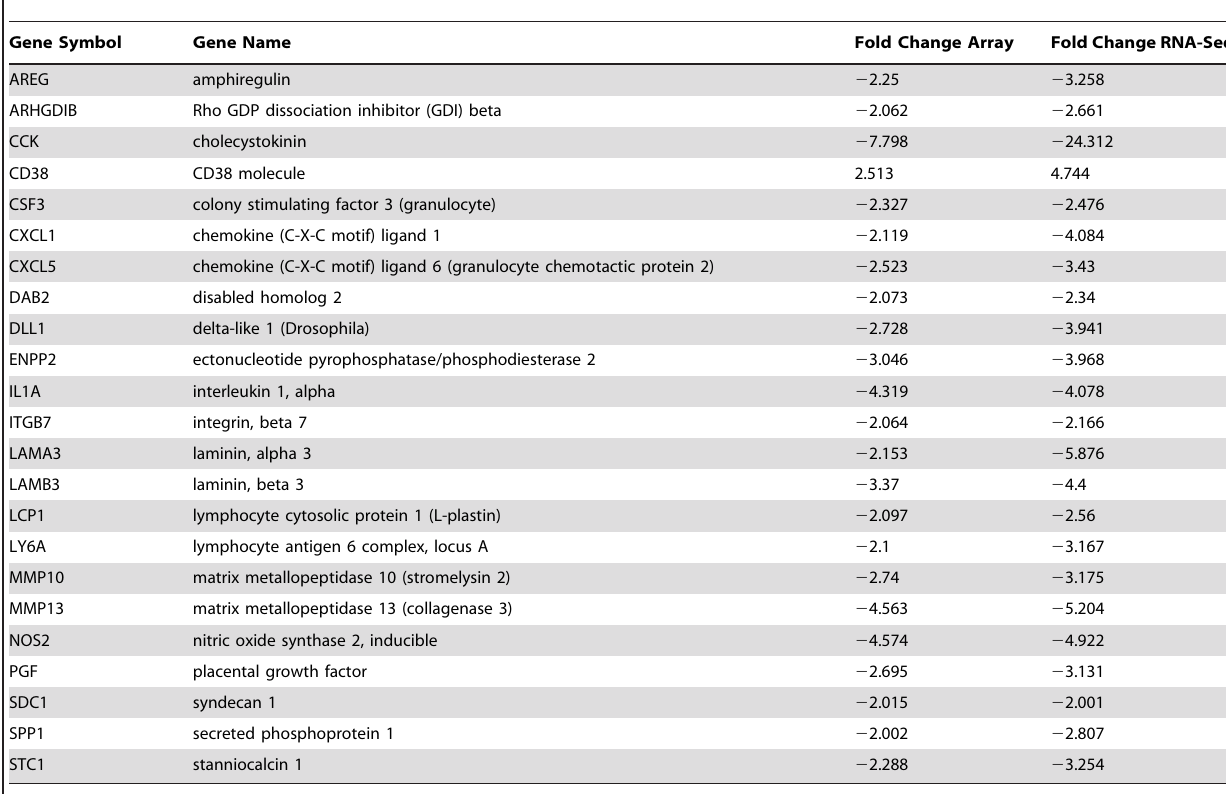
Gene Symbol Fold Change